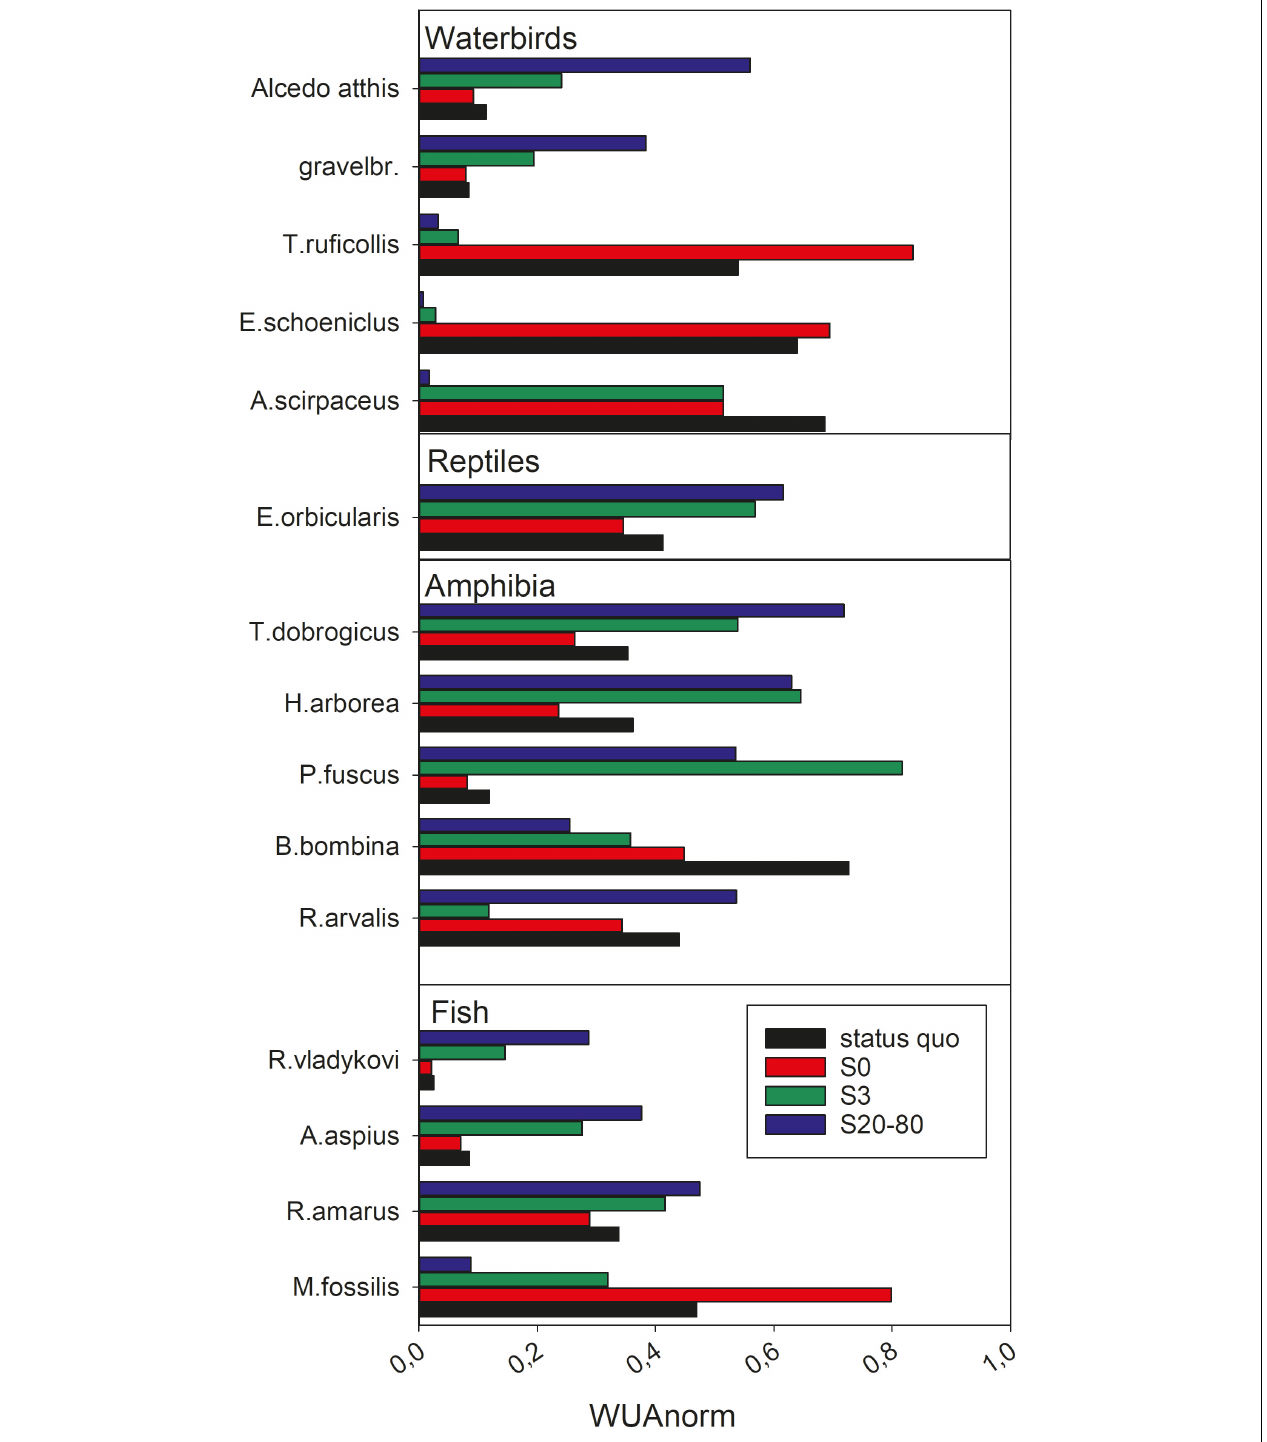
FIGURE 5 | Summarized normalized WUA values for selected species protected by the HBDs for the three scenarios and the modeled status quo . Alcedo atthis (kingfisher), gravelbr.: gravelbreeding water bird species (common sandpiper, Actitis hypoleucos and little ringed plover, Charadrius dubius ), Tachybaptus ruficollis (little grebe), Emberiza schoeniclus (reed bunting), Acrocephalus scirpaceus (reed-warbler), Emys orbicularis (European pond turtle), Triturus dobrogicus (Danube crested newt), Hyla arborea (European tree frog), Pelobates fuscus (common Eurasian spadefoot toad), Bombina bombina (fire bellied toad), Rana arvalis (moor frog), Romanogobio vlaycovi (white-finned gudgeon), Aspius aspius (asp), Rhodeus amarus (European bitterling), Misgurnus fossilis (weatherfish). Only species protected under HBDs are displayed.